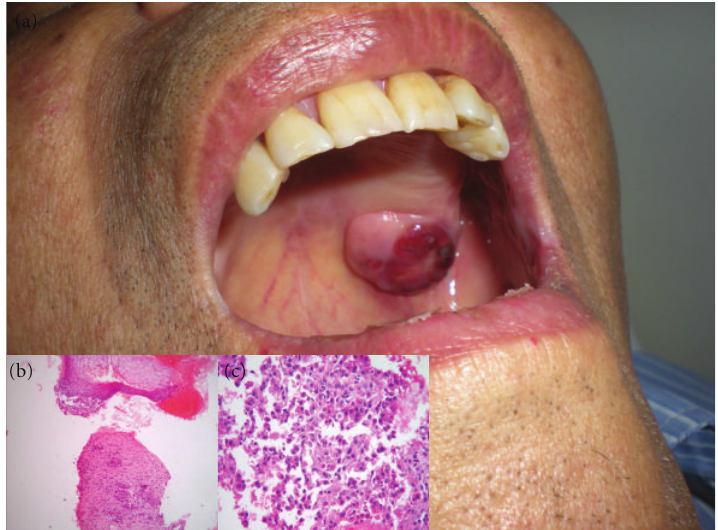
Figure 1: (a) Patient oral cavity showing 2 cm exophytic mass in the left retromolar trigonum; biopsy from the oral mass (hematoxylin and eosin stain) demonstrates infiltration by carcinoma of nodular and glandular pattern, consisting of atypical cuboidal cells with slightly